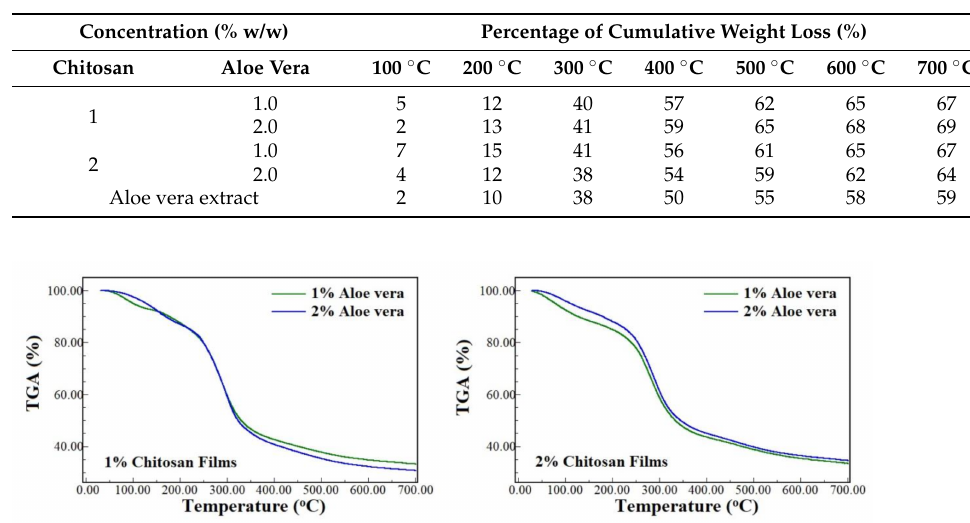
Table 4. Percentage weight loss obtained by thermogravimetric analysis of chitosan powder, aloe vera extract, and chitosan films with aloe vera extract.